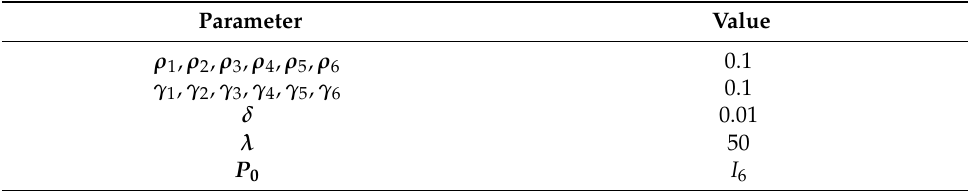
Table 2. Values of adaptation